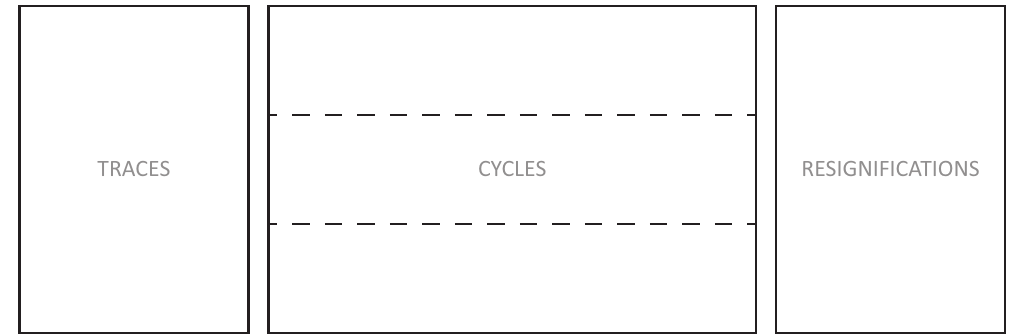
Figure 1. Schematic presentation of the North Quarter’s triptych as interpreted by the